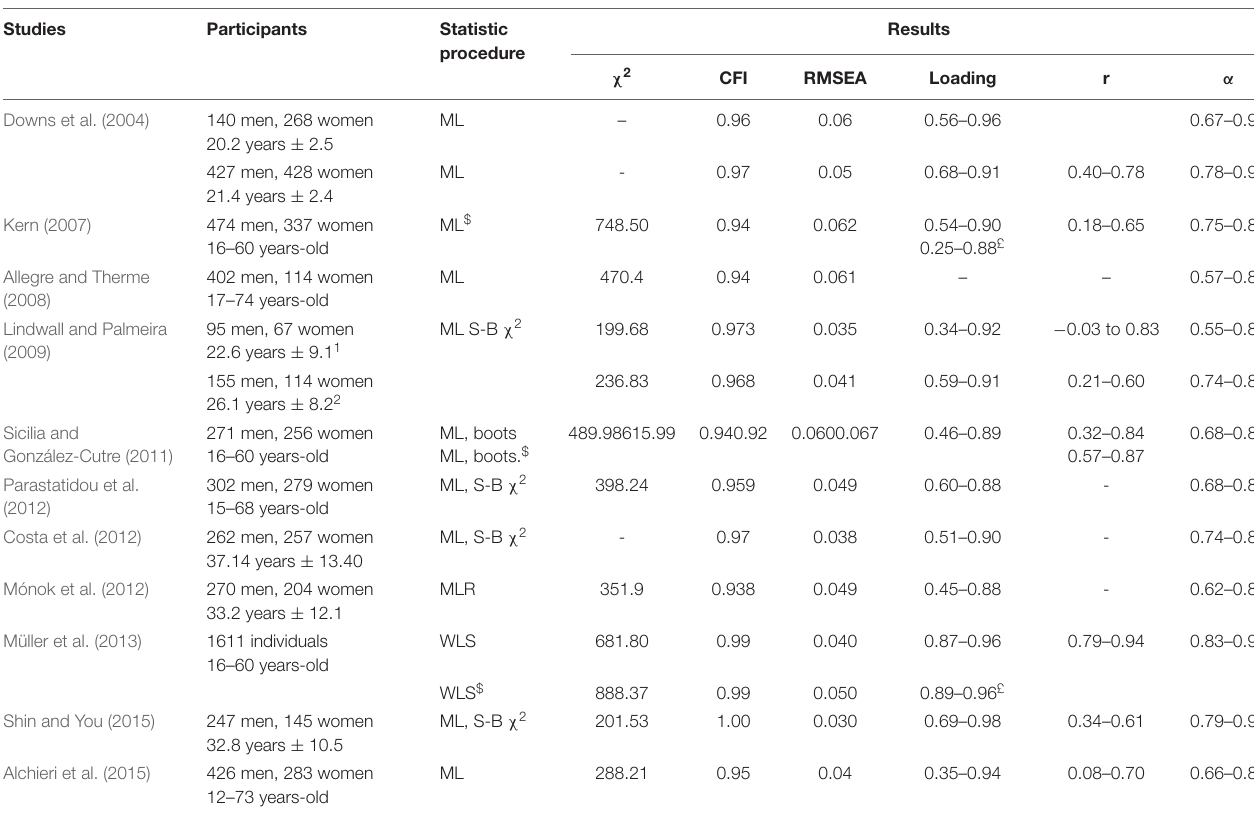
TABLE 1 | Summary of